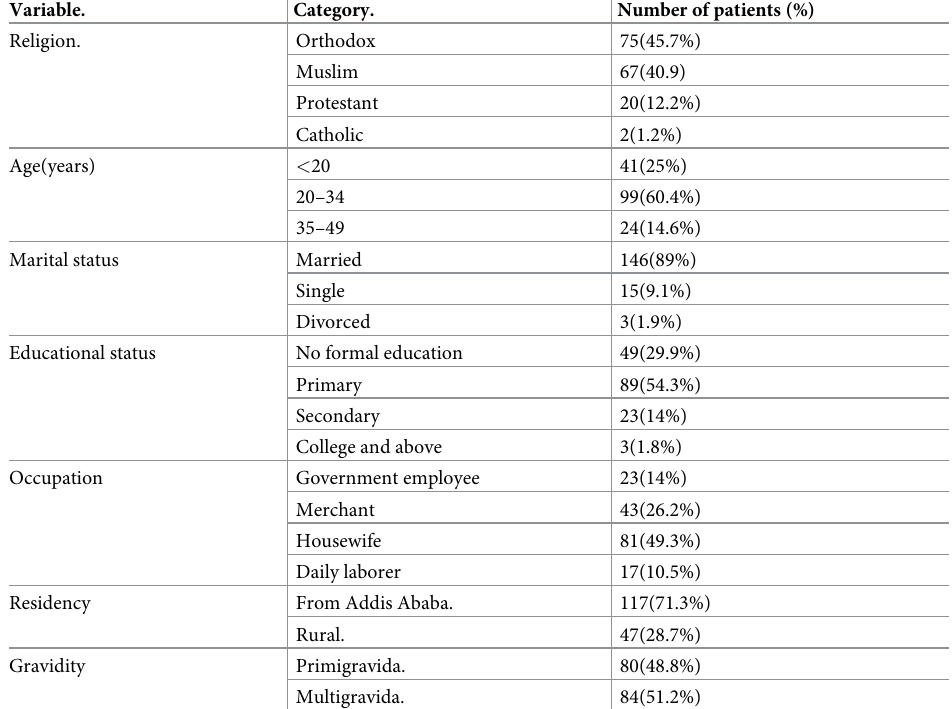
Table 1. Socio demographic and obstetric characteristics of mothers on expectant management with a diagnosis of preeclampsia without severe feature at SPHMMC,2018 (N = 164).